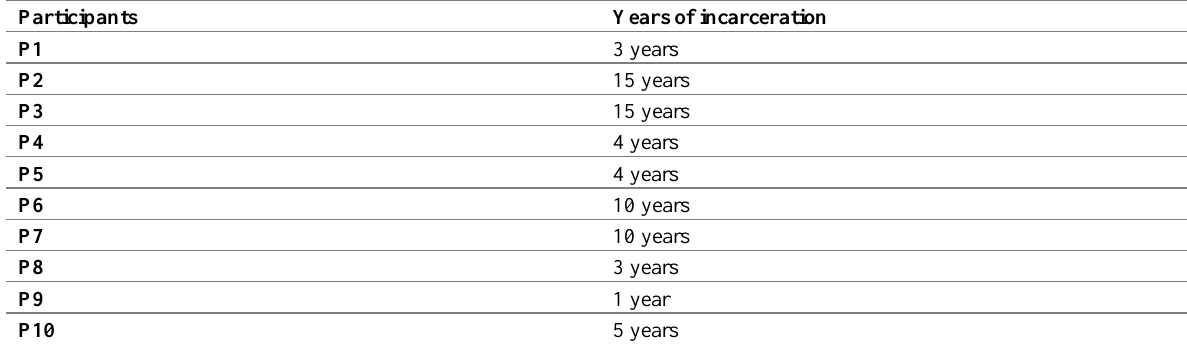
Table 2: Duration of participants’ incarceration